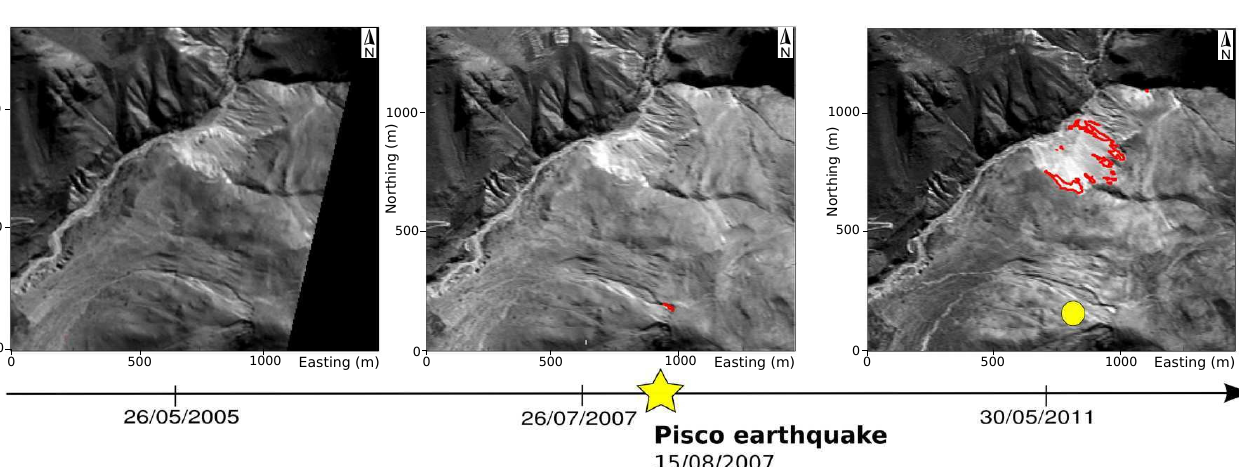
Figure 6. Image subsets over the same area (of 1.2 × 1.4 km 2 ) at different dates surrounding the Pisco earthquake. The red contours correspond to the 2 new landslides detected by the automatic procedure described in this paper: one occurring between 26 May 2005 and 26 July 2007 (middle image), and the largest one occurring between 26 July 2007 and 30 May 2011 (right image). The yellow point corresponds to a 150 m 3 landslide assumed to be triggered by the earthquake in the field inventory (13.17 ◦ S 75.64 ◦ W), which fits well with the first landslide detected by the automatic method but before the